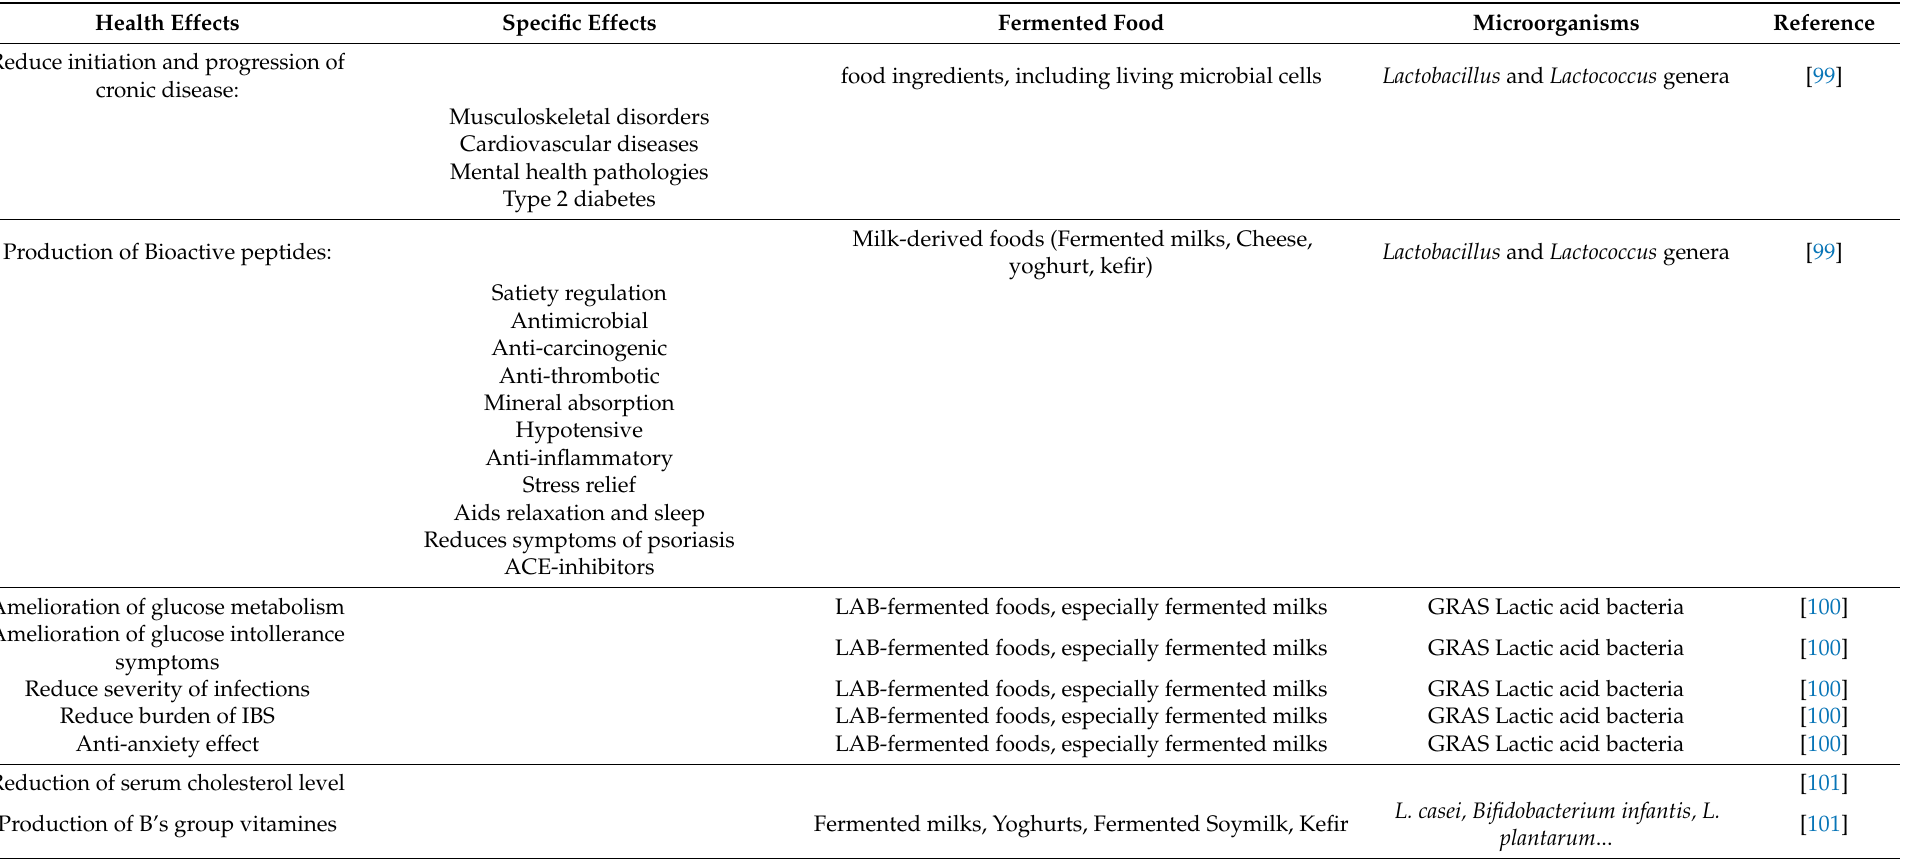
Table 2. Health-related effects of fermented dairy